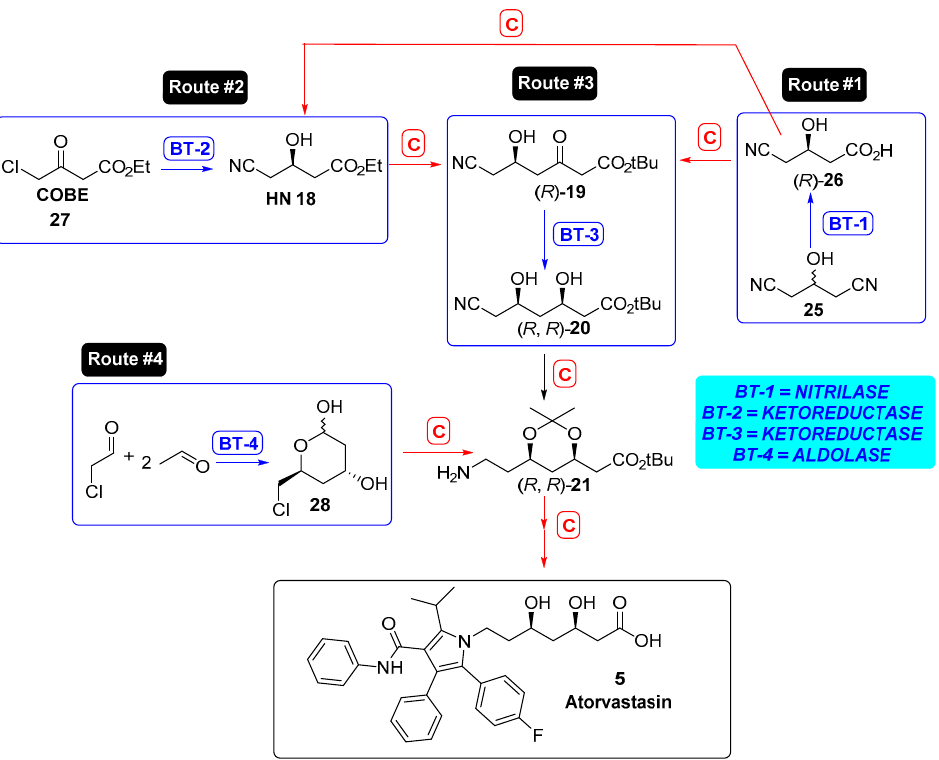
Figure 6. Biocatalytic retrosynthetic routes to atorvastatin. BT represents biotransformation